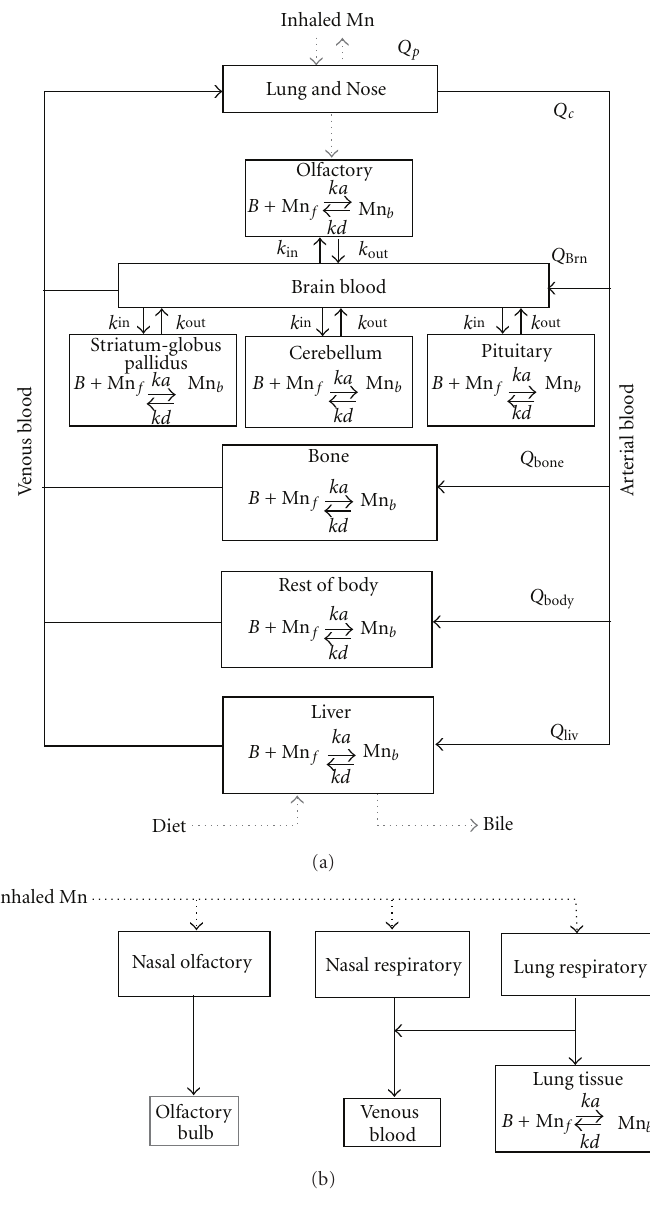
Figure 1: The PBPK model structure developed by Nong and coworkers [14] describing tissue manganese kinetics in adult rats. The overall PBPK model structure is shown in (a); an expanded view of the respiratory tract modeling is shown in (b). Inhaled manganese is absorbed through deposition of particles on the nasal and lung epithelium. Most of the manganese deposited in the nasal cavity is absorbed into the systemic blood while a small fraction undergoes direct delivery to the olfactory bulb. Every tissue has a binding capacity, B max , with a ffi nity defined by association and dissociation rate constants ( k a , k d ). Free manganese moves in the blood throughout the body and is stored in each tissue as bound manganese. Influx and e ffl ux di ff usion rate constants ( k in , k out ) allow for di ff erential increases in manganese levels for di ff erent tissues. Q p , Q c , Q tissue refer to pulmonary ventilation, cardiac output, and tissue blood flows. Reprinted from [14] (with permission).